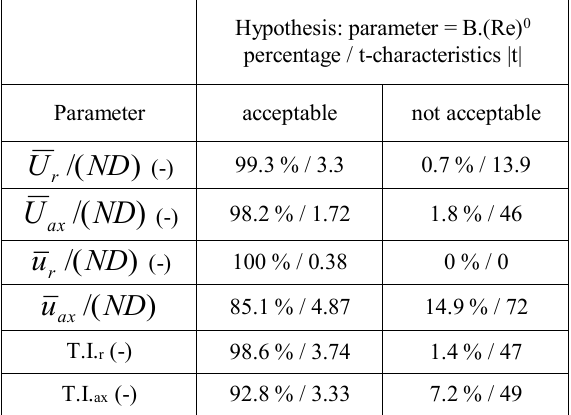
Table 2. Dimensionless velocities – effect of the impeller